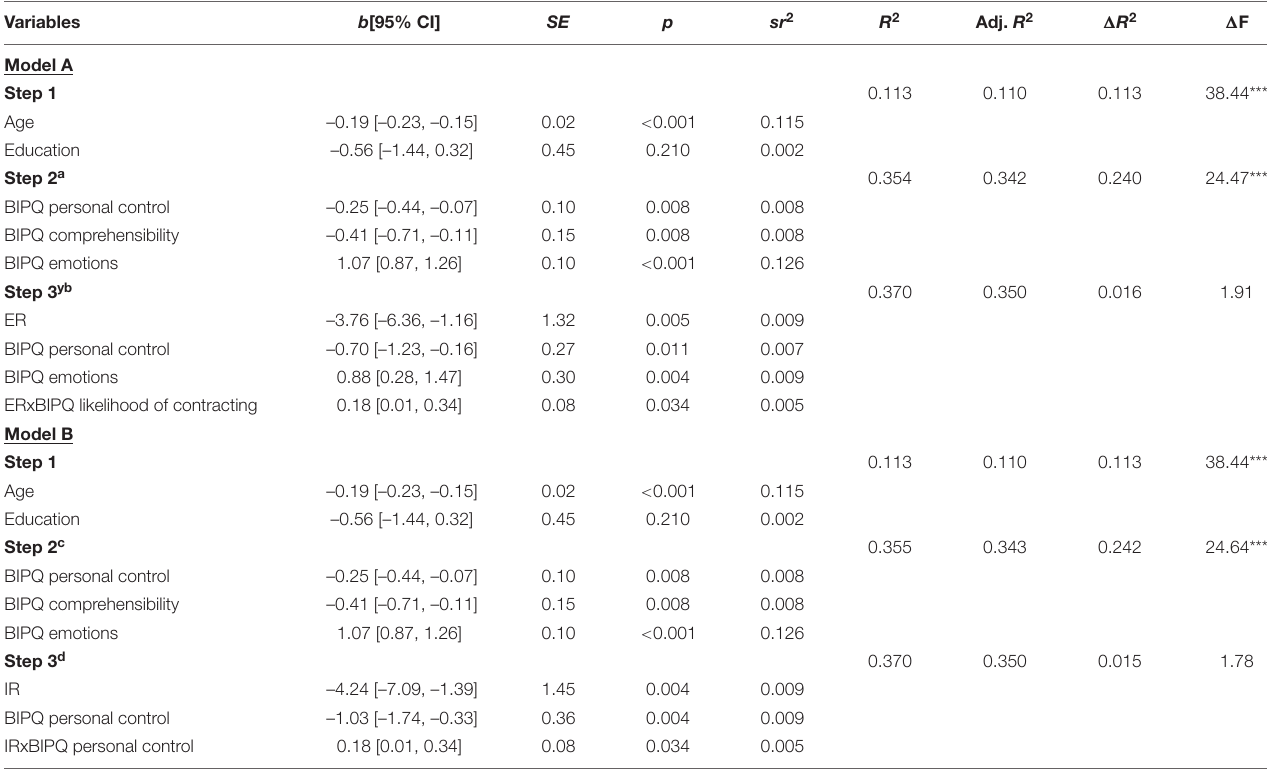
TABLE 4 | Regression coefficients for the relationship between illness perception and perceived stress moderated by religious expressions.